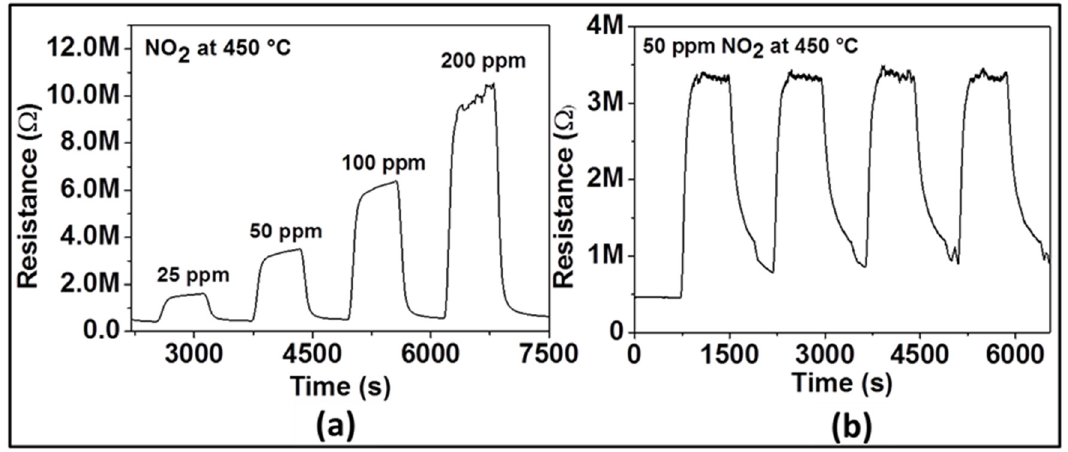
Figure 4. Dynamic response of gas sensor based on ZnO thin film to various concentrations of NO 2 ( a ) and to 50 ppm NO 2 ( b ) at an optimal operating temperature of 450 °C. Response and recovery times are important sensor characteristics for real-time measurement.